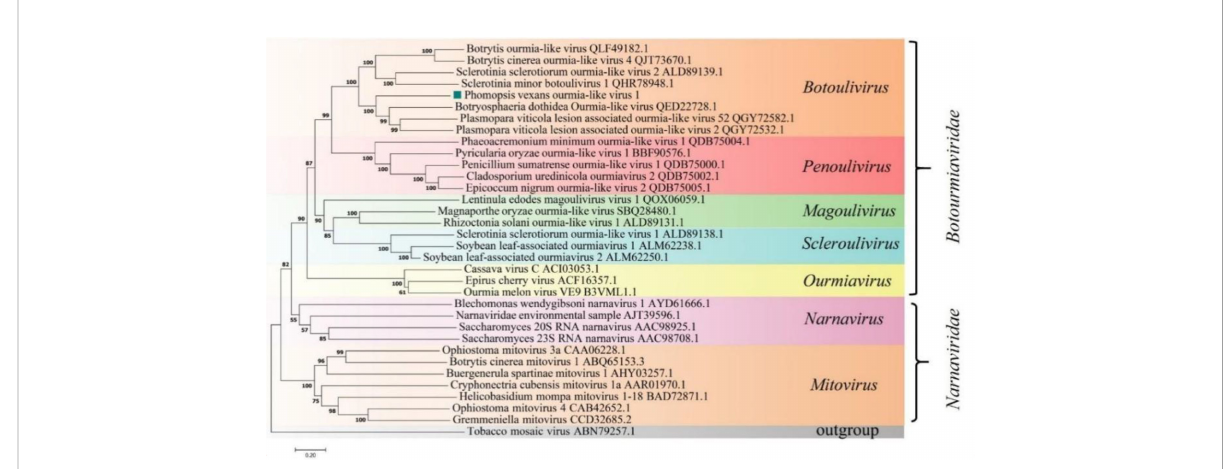
FIGURE 7 Phylogenetic analysis of PvOLV1. Phylogenetic analysis of PvOLV1 based on aa alignments of RdRp and other viruses related to these proteins. A phylogenetic tree was constructed by the neighbor-joining algorithm using MEGA7, with 1000 bootstrap replications. The percentage of bootstrap values supporting the branches in phylogenetic trees are indicated on the nodes. The genetic distance is represented by the scale bar of 0.2 aa substitutions per site. The novel virus PvOLV1 is indicated by a green square. The names and database accession numbers of other related viruses analyzed are indicated in the